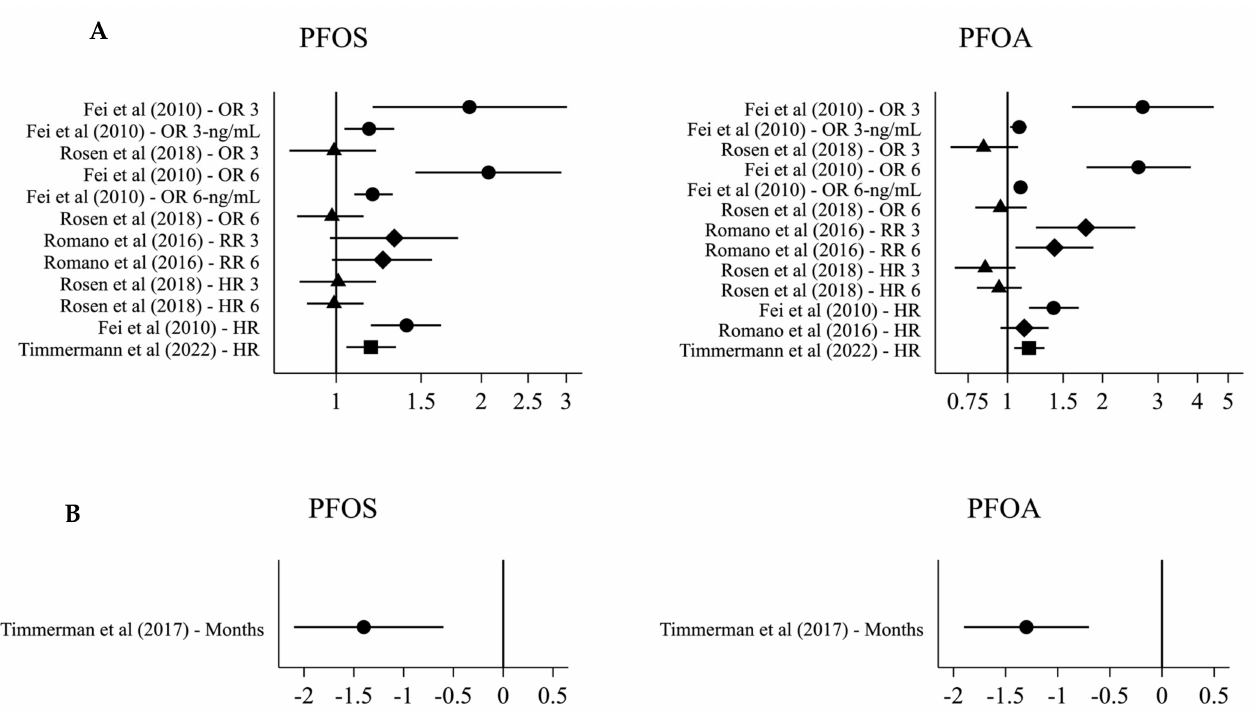
Figure 3. Effect estimates for the association between serum PFOS/PFOA and breastfeeding. ( A ) OR 3/6: odds ratio for termination by 3/6 months for the highest compared to the lowest PFAS quartile Fei et al. (2010) [40], or with an interquartile range difference in PFAS Rosen et al. (2018) [42]. OR 3/6-ng/mL: odds ratio for termination by 3/6 months for each 1 ng/mL PFOS/10 ng/mL PFOA in-crease. RR 3/6: relative risk of termination by 3 months for the highest compared to the lowest PFAS quartile. HR 3/6: hazard ratio for termination at 3/6 months with an interquartile range dif-ference in PFAS. HR: HR for terminating breastfeeding for the highest compared to the lowest PFAS quartile Fei et al. (2010) [40], or with each doubling of PFAS Timmermann et al. (2022) [43] and Romano et al. (2016) [45]. ( B ) months difference in breastfeeding duration with each doubling of